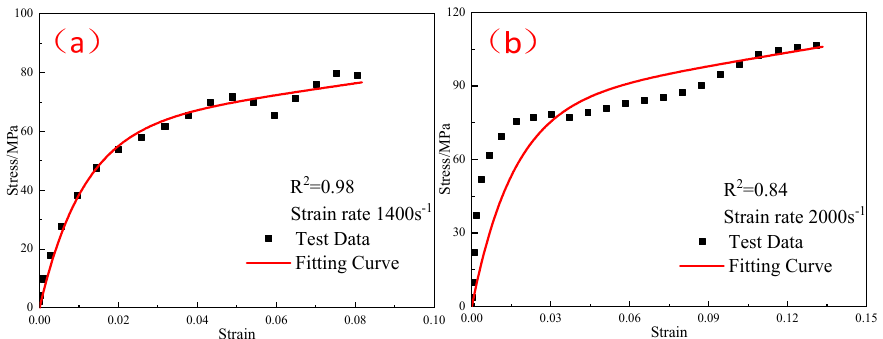
Figure 22. Comparison of the fitting results of the ZWT constitutive model with the experimental results under different strain rates at − 30 °C: ( a ) 1400 s − 1 ; ( b ) 2000 s − 1 .